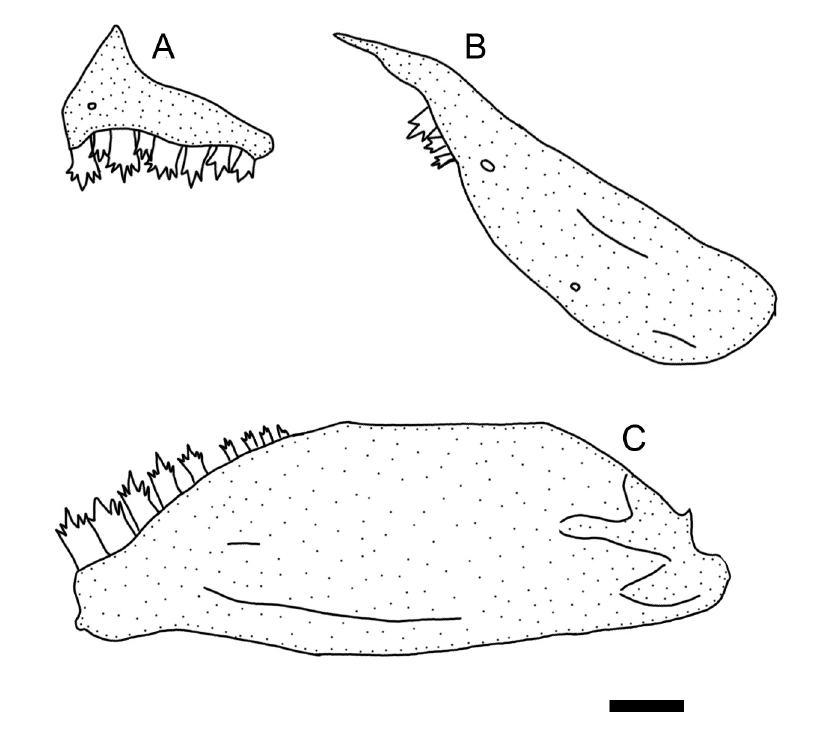
Fig. 6. Hyphessobrycon geryi Guimarães, Brito, Bragança, Katz & Ottoni sp. nov. (CICCAA 02402), 23.2 mm SL. Jaw suspensory. A . Premaxillary. B . Maxilla. C . Dentary. Scale bar: 1